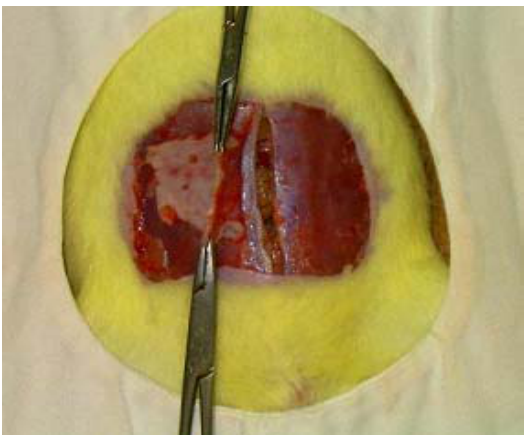
FIGURE 4: Longitudinal incision in Linea Alba